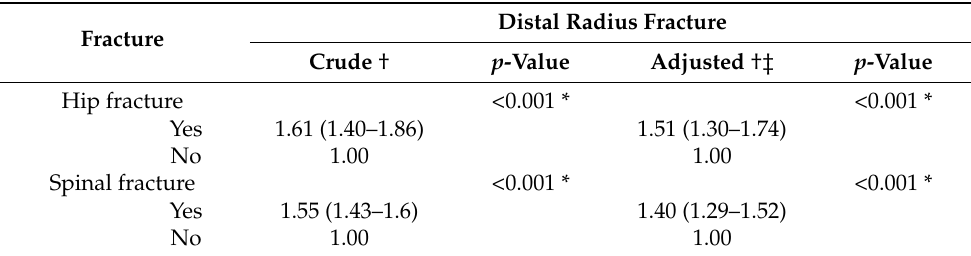
Table 2. Crude and adjusted hazard ratios (95% confidence interval) of distal radius fracture for hip and spinal fracture in total participants (n = 40,075).